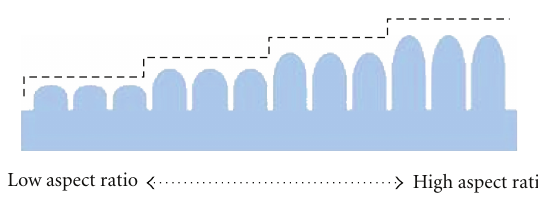
Figure 3: Gray scale microlens array.